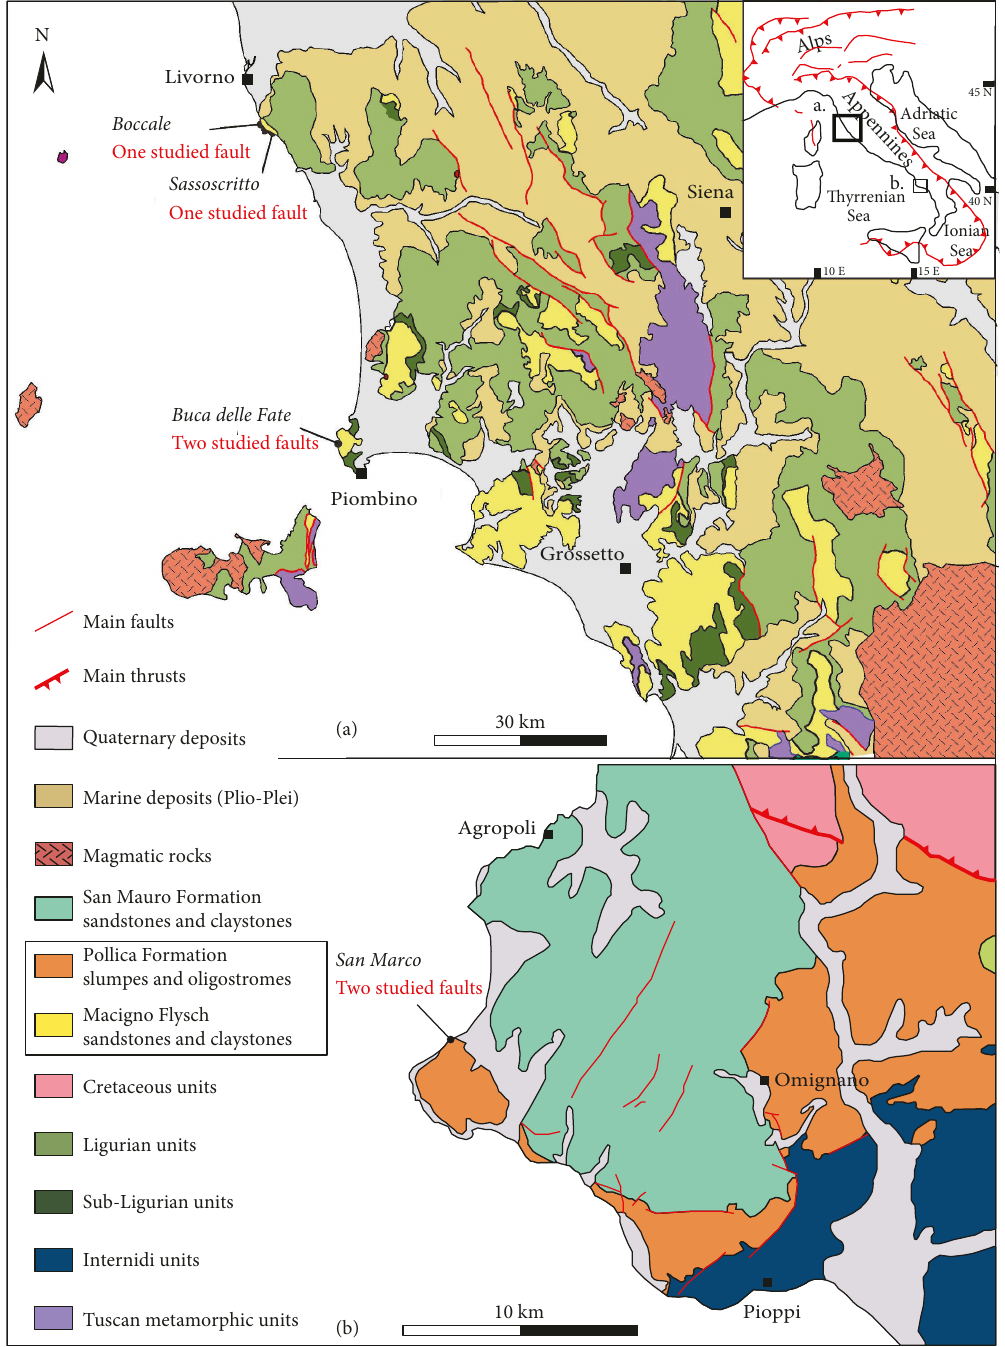
Figure 2: Locations of study areas along with key sites denoted in italics. The focused geologic formations are denoted inside the rectangle. (a) Livorno-Piombino area [47], (b) Agropoli-Pioppi area (San Marco di Castellabate)